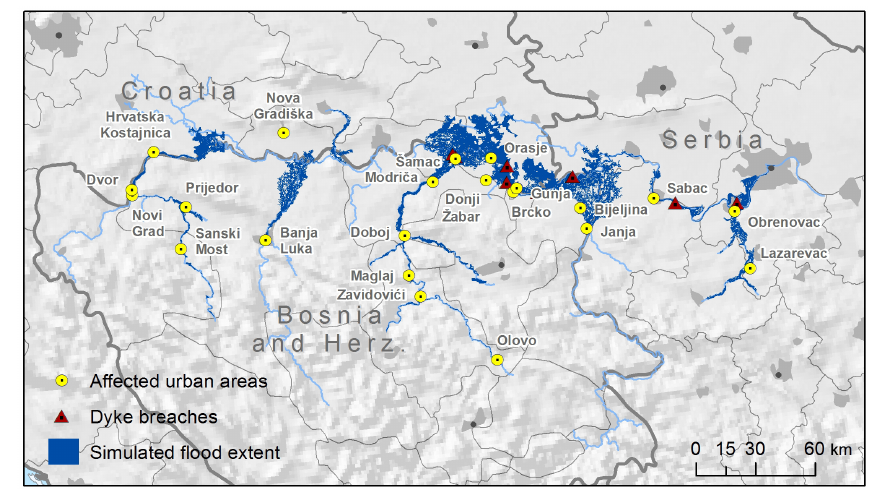
Figure 4. Reconstruction of affected urban areas and dyke failure locations along the Sava River (sources: UNDAC, 2014; ICPDR and ISRBC, 2015). The flood extent of the reference simulation with the proposed procedure is also shown (see Sect. 3.2). Table 1. Summary of flood impacts at national